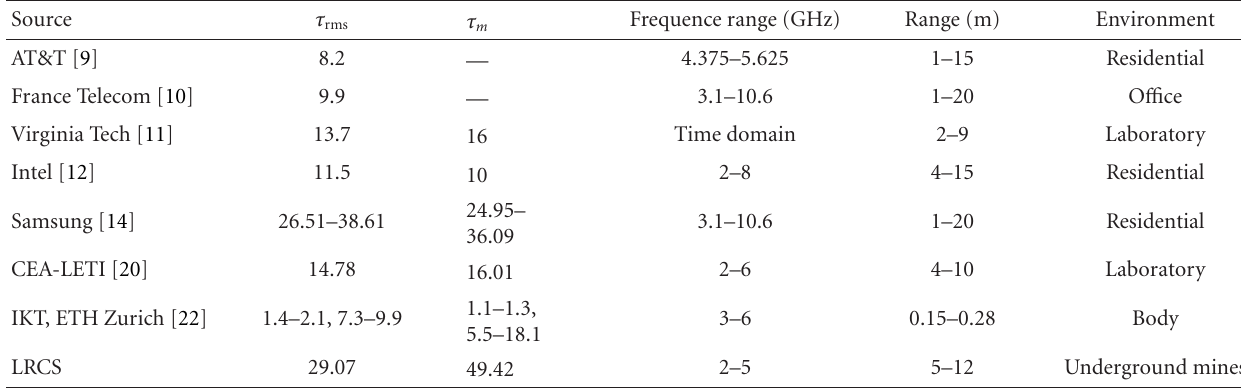
Table 4: Results about time-domain parameters in previous measurement campaigns for NLOS